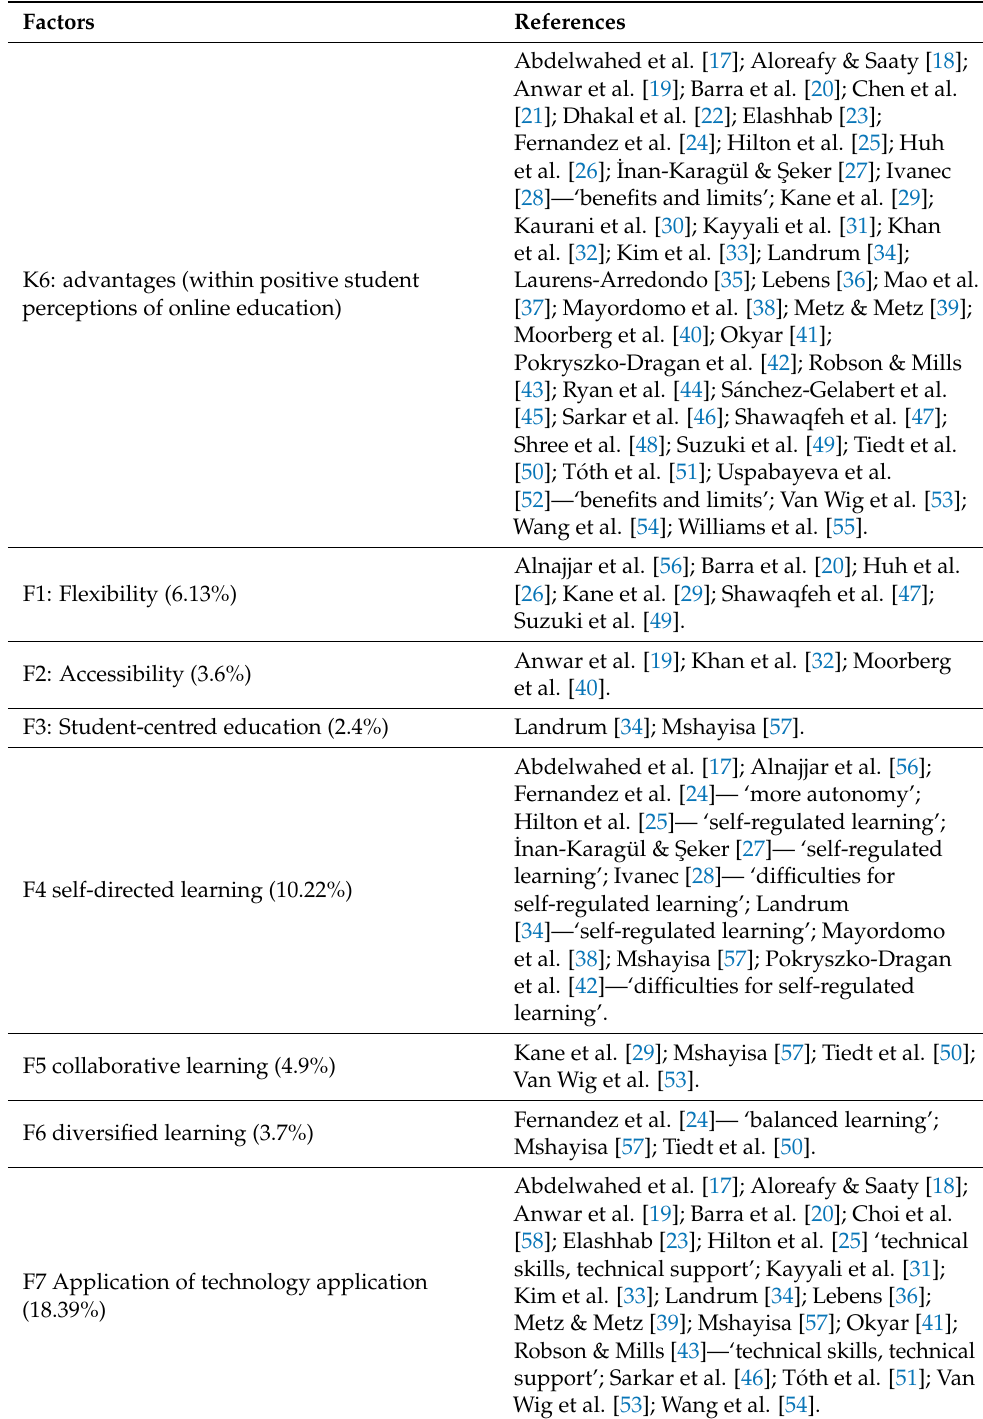
Table 2. Literature focusing on students’ positive perceptions of online